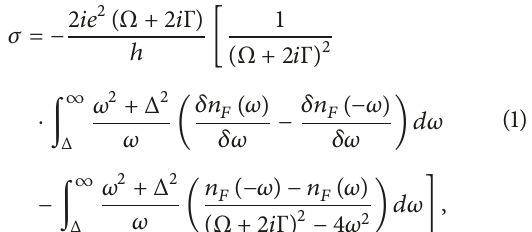
where Ω is optical frequency, 𝑛 𝐹 (𝜔) is the Fermi distribution function, Γ(𝜔) is the scattering rate, 𝜔 is the energy of the relativistic Landau levels, and Δ is the exciton gap of Landau level energies. The calculated graphene’s optical conductivity 𝜎 with respect to Fermi level and frequency is shown in Figure 1. For a given wavelength, for example, 1550 nm as indicated in Figure 1, when the Fermi level is less than half of the photon energy ( ∼ 0.4 eV), the real part of the optical conductivity is almost a universal value ( ∼ 61 𝜇 S) which is governed by the interband transition. When the Fermi level is larger than half of the photon energy, the real part of the optical conductivity drops significantly since interband transition is blocked due to Pauli blocking